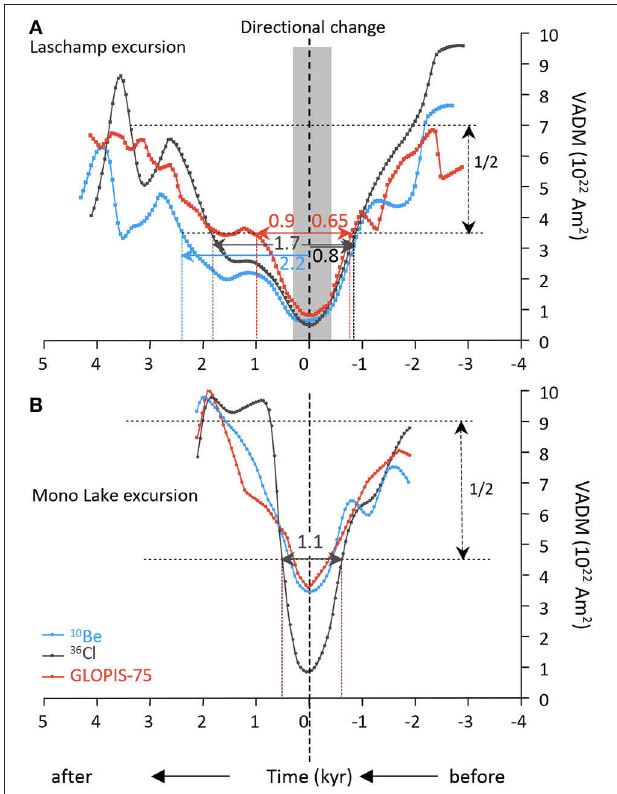
FIGURE 4 | Laschamp (A) and Mono Lake excursions (B) recorded in GLOPIS-75 ( Laj et al., 2004) and in ice via the 10 Be (Muscheler et al., 2004) and 36 Cl (Wagner et al., 2000a) concentrations in Greenland ice reported vs. a time scale where 0 is the occurrence of the geomagnetic dipole minimum. Negative (positive) numbers are for the time before (after) the excursions. The gray bar indicates, accordingly to Figure 3 , the duration of the inclination change during the Laschamp excursion. The duration of the geomagnetic dipole lows are evaluated as the width at mid-height (indicated by the two dashed lines and “1/2”). This duration during the Laschamp excursion (in A ) is reported for each record (with the same color as the records themselves) before and after the intensity minimum value. For the Mono Lake excursion (B) , it is reported for the 36 Cl record because it is the most detailed